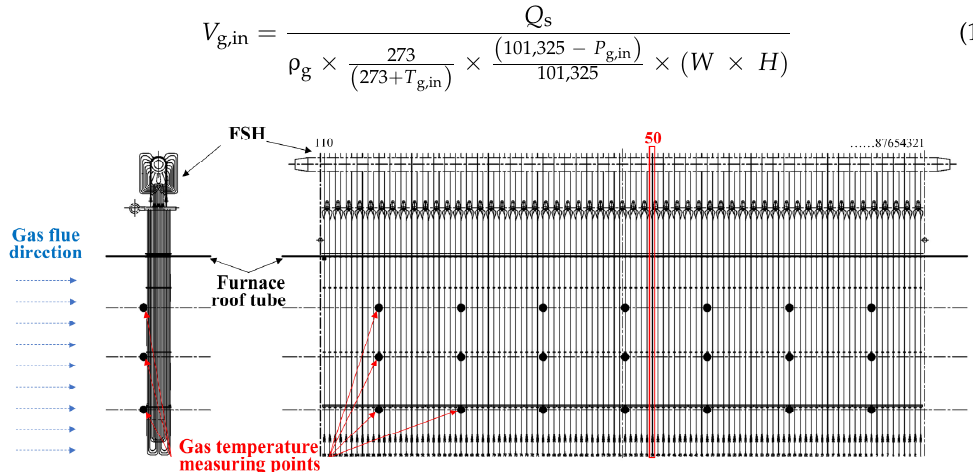
Figure 3. Layout of flue gas temperature measuring points on the inlet flue section of the FSH.